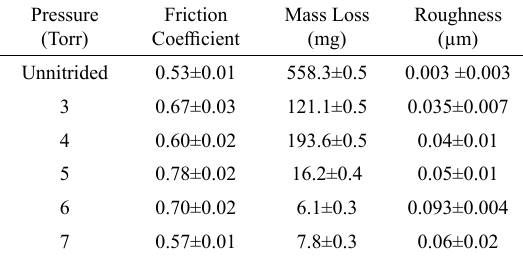
Table 1. Measurements of surface roughness, friction coefficient and mass loss during wear test.